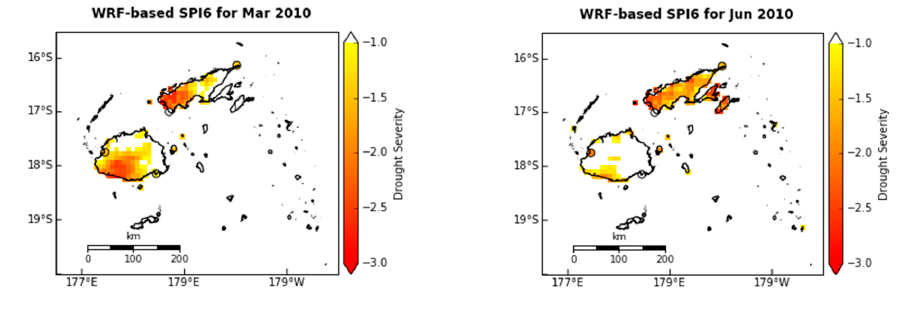
Figure 8. Scatter plots of reference SPI6 vs. 3-month lead SPI6 predictions for testing based on ( a